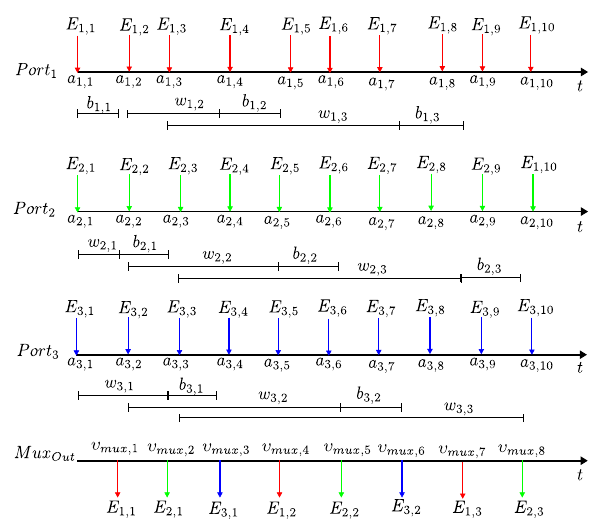
Figure 3: a) Multiplexer model b) De-multiplexer model.